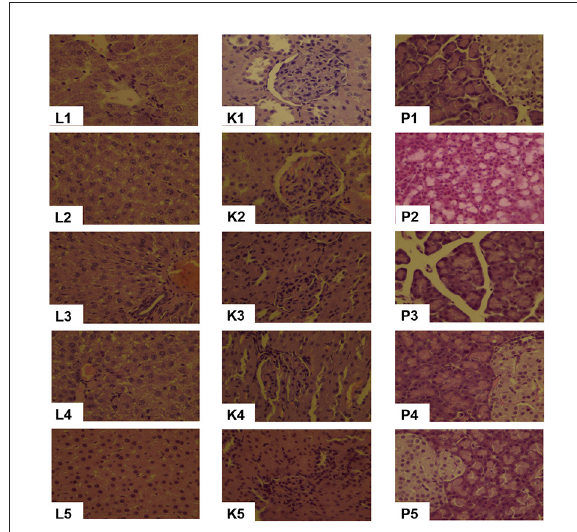
FIGURE3 Effects of supplementation of serine-deprived diet with serine (0.5, 1.0, and 2.0 times the amount of serine in 20C) on Liver (L1–L5), Kidney (K1–K5) and Pancreas (P1–P5) pathological changes (10 × ) in rats fed 20C (experiment 1). 1, 20C; 2, 20CSD; 3, 20CSD + 0.5 × Ser; 4, 20CSD + 1.0 × Ser; 5, 20CSD + 2.0 × Ser.